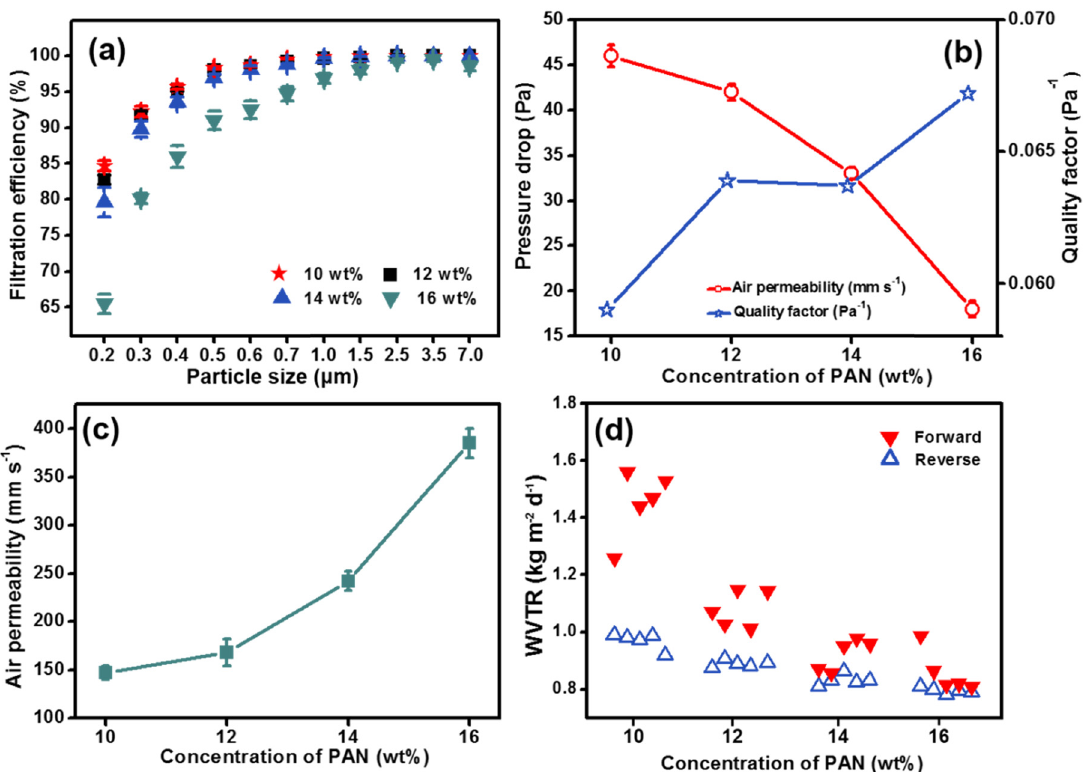
Figure 3: Filtration e ffi ciency ( a ) , pressure drop ( b ) , air permeability and QF ( c ) , and WVTR ( d ) of PAN/PEI composite membranes with varying PAN concentrations. The basis weight of the composite NFMs was 0.6 g m − 2